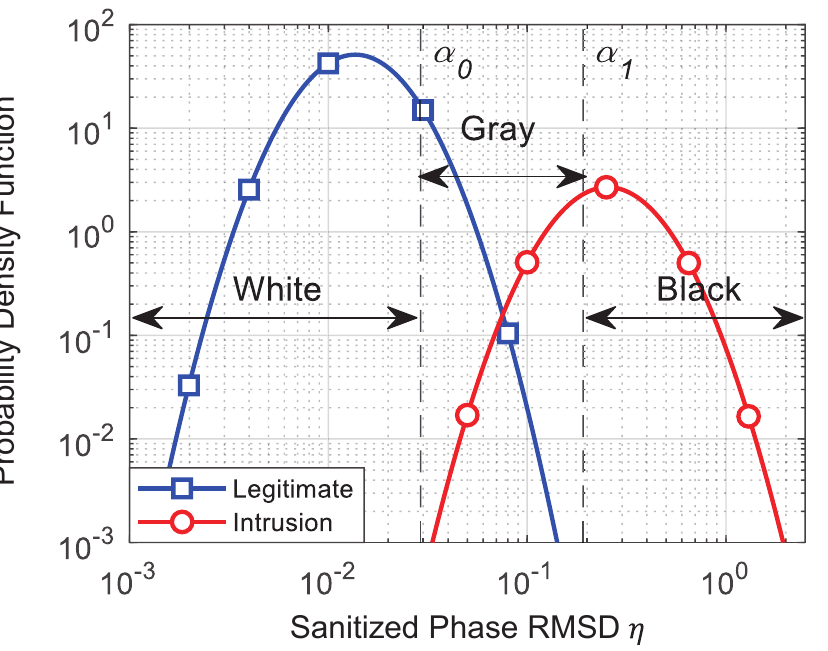
Figure 8. PDFs of RMSD for